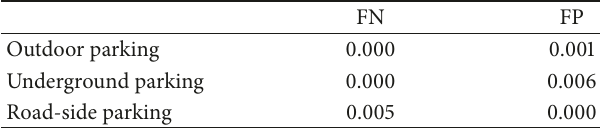
Table 5: FN and FP rate in different environmental conditions. FN FP Outdoor parking